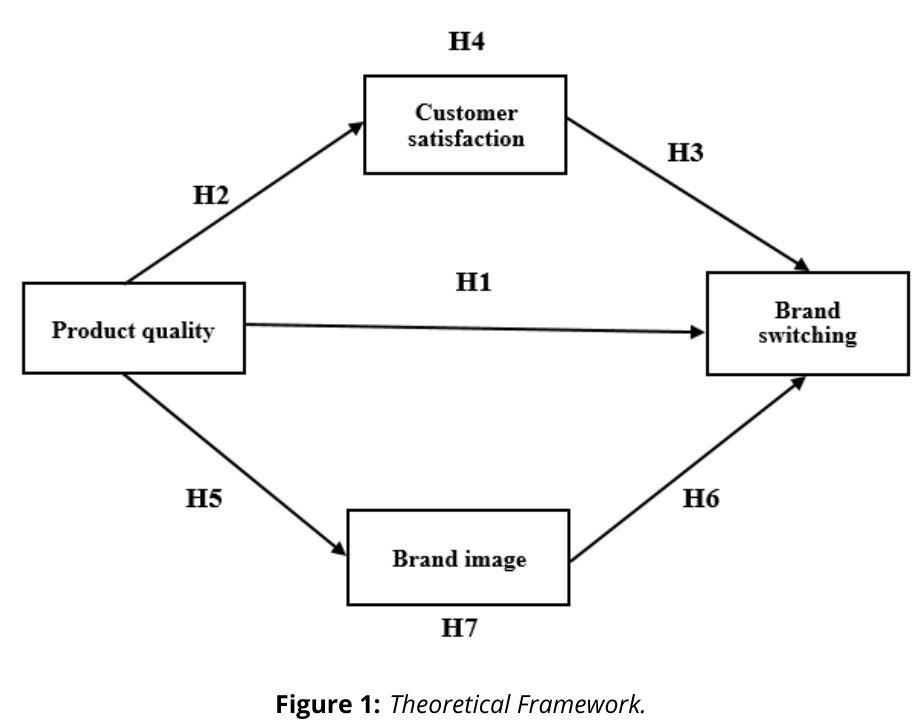
Figure 1: Theoretical